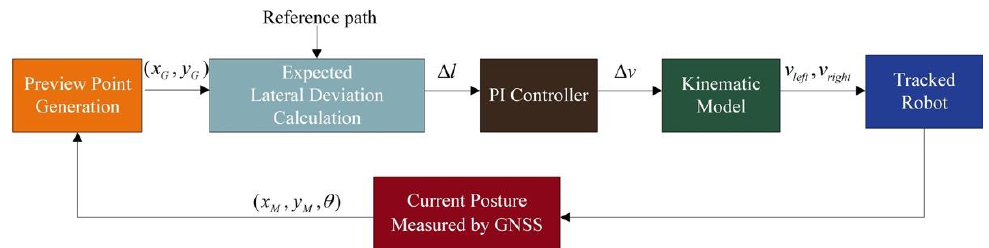
Figure 3. Schematic diagram of robot posture adjustment.